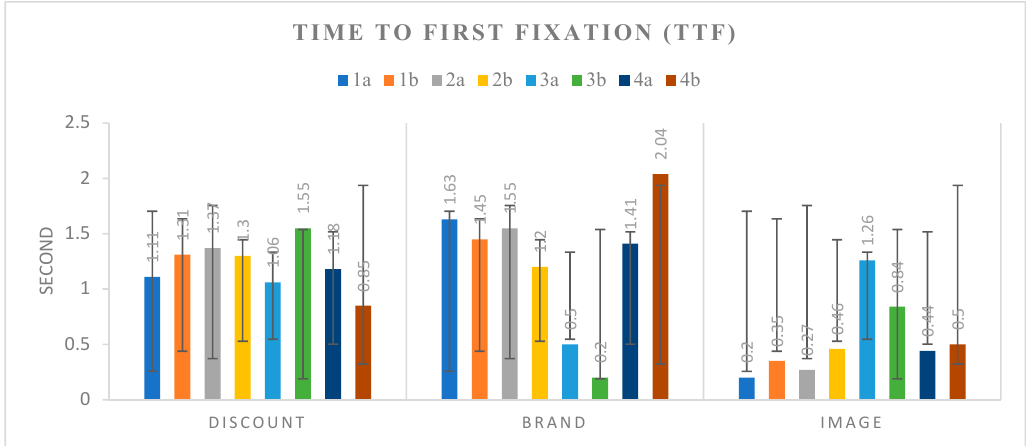
Figure 4. Distribution of Time to First Fixation in seconds for the banners in the three AOIs. In order to determine whether the banner types had a significant impact on the at- tention captured by each AOI, RM-ANOVAs were performed on the eye-tracking data for each of the three defined AOIs. The results of the RM-ANOVAs of which the related as- sumptions were confirmed, and the post hoc tests reflecting a significant difference are given in the column of post-hoc comparisons in Table 2. The results revealed significant differences across the eight banners for all three banner content elements, namely discount information, image, and brand. As indicated in the table, concerning the FC and TVD measures, there was a significant effect of banner type on the visual attention paid to the discount information (F (7,175) = 6.995, p < 0.001), F (7,175) = 6.497, p < 0.001)) and image (F (7,182) = 5.798, p < 0.001), F (7,182) = 8.233, p < 0.001)) areas, respectively. Besides this, regarding the TTF measure, the results showed that there was a significant effect of the banner type on the visual attention paid to the brand area (F (7, 119) = 10.244, p < 0.001)). Table 2. Test results demonstrating the influence of the banner types on the visual attention. AOI